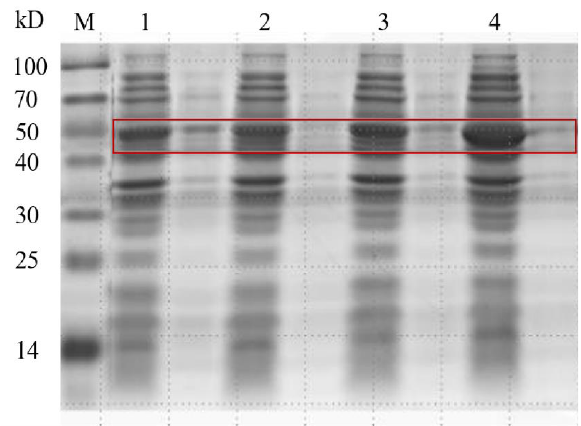
Figure 1. Expression and analysis of molecular weight of different modified Melac13220 using SDS- PAGE. Lane M: protein marker; lane 1: Melac13220; lane 2: Melac13220-DQ; lane 3: Melac13220-NQ; lane 4: Melac13220-CQ.